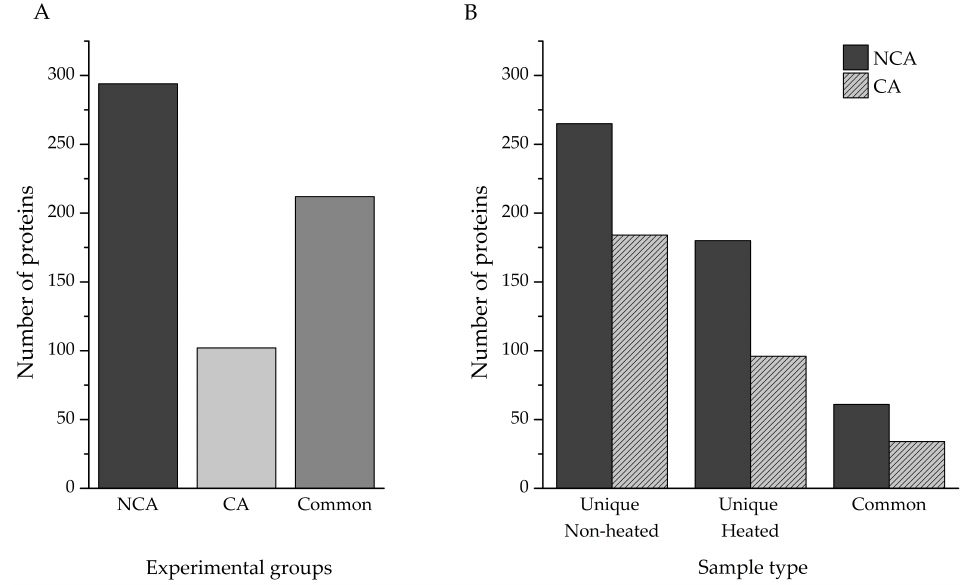
Figure 2. ( A ) Total unique and common proteins isolated from different experimental groups. ( B ) Effect of sample heating on the number of identified proteins. Unique Non-heated—proteins found only in the non-heated samples; Unique Heated—proteins found only in heated samples; Common—proteins that were found in both heated and non-heated samples; NCA—non-cold- acclimated diapausing group; CA—cold-acclimated diapausing